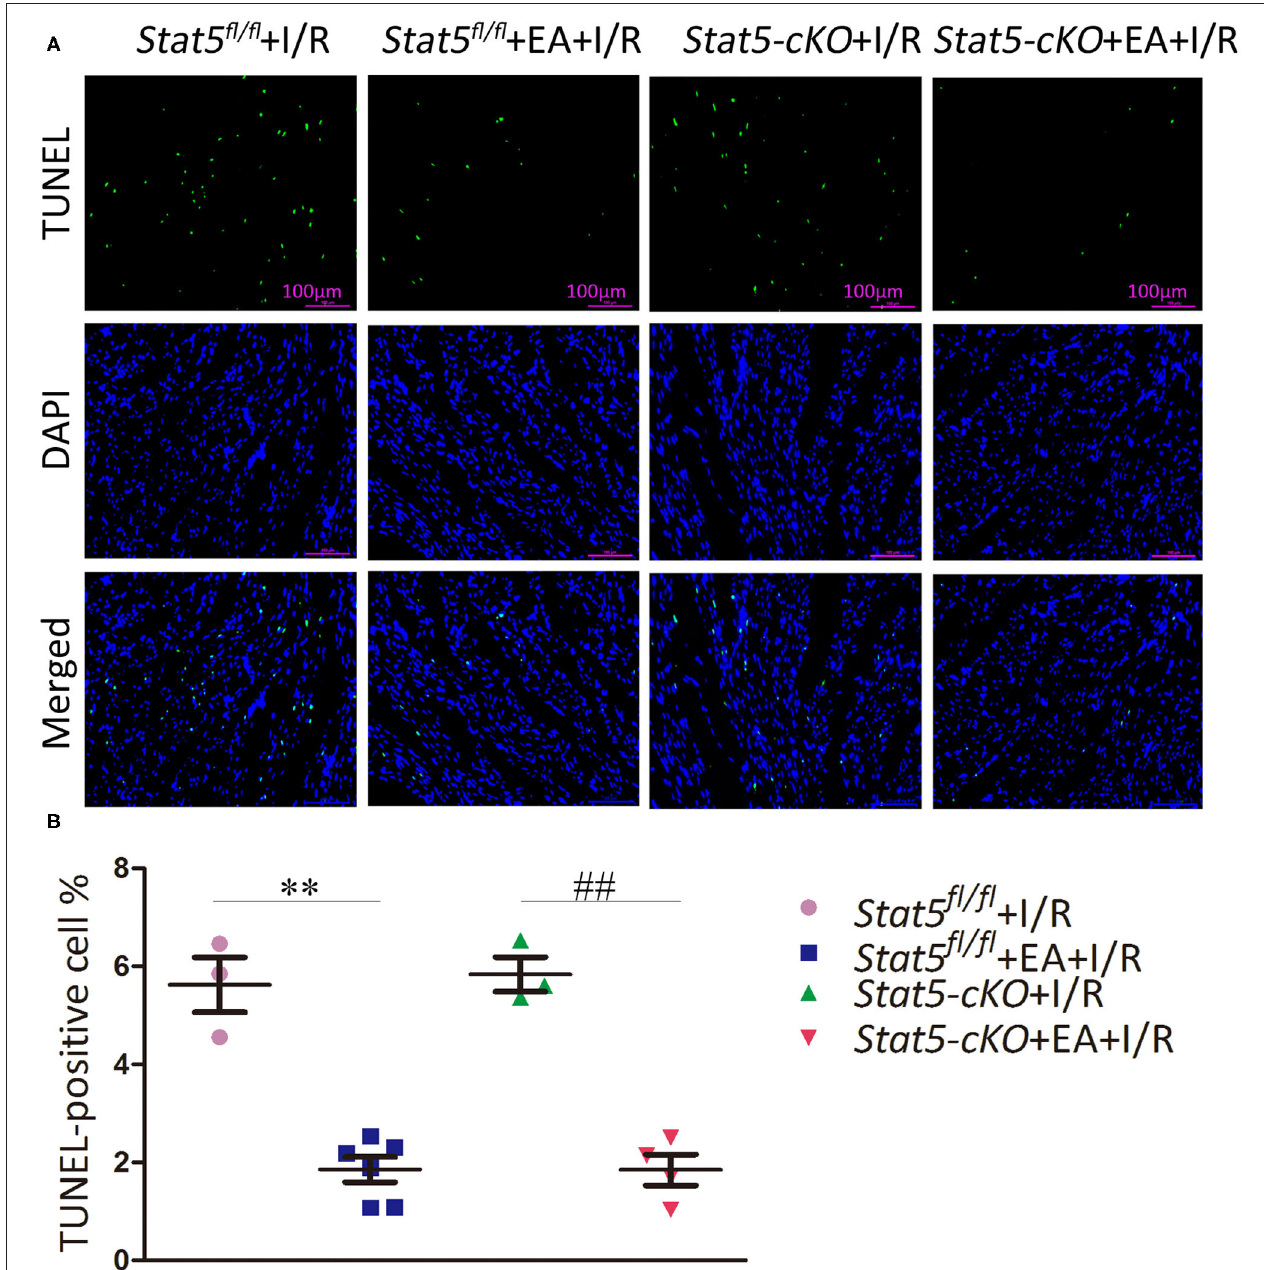
FIGURE 2 | The effects of electroacupuncture pretreatment (EAP) on apoptosis in myocardial tissues in the Stat5 fl / fl and the Stat5- cKO mice. (A,B) The rate of apoptosis was measured by TUNEL staining. Values are means ± SEM. ** P < 0.01 compared with the Stat5 fl / fl + I/R group; ## P < 0.01 compared with the Stat5- cKO + I/R group. Data were analyzed by two-way ANOVA with Bonferroni’s multiple comparison test, n = 3–6.